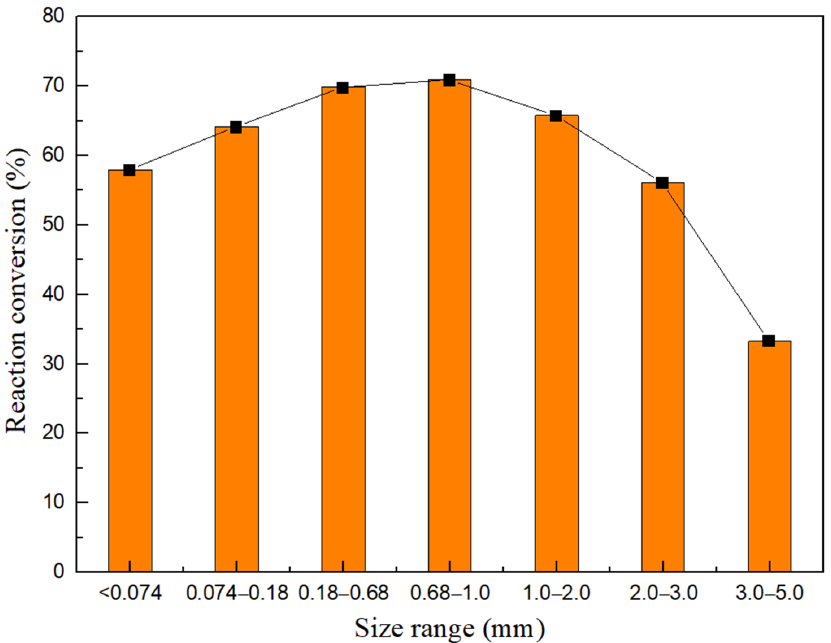
Figure 5. Conversion of limestone with different particle sizes during calcination for 60 s.